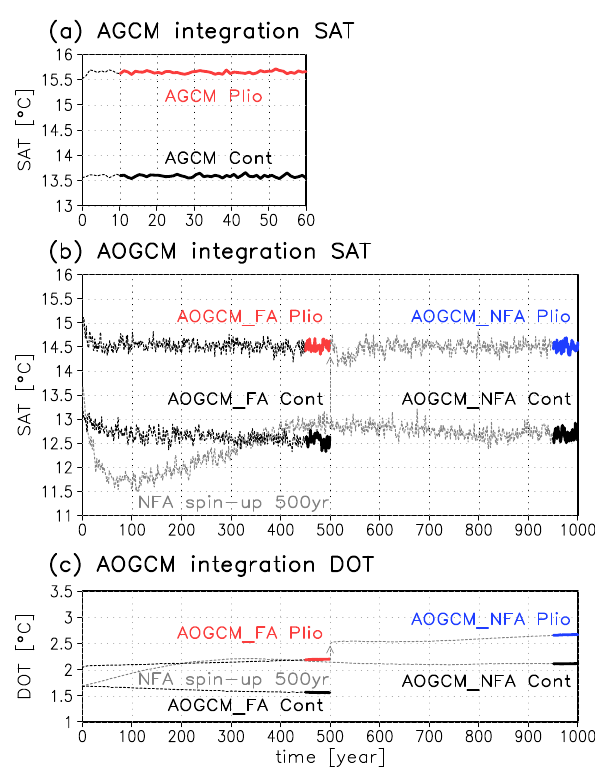
Fig. 3. Time series of the model integrations including spinups. Bold solid lines show the averaging periods of the individual simulations. (a) Globally averaged surface air temperature (SAT, °C) for the AGCM and (b) AOGCM. (c) Same as (b) but for deep ocean temperature (DOT, °C) averaged for depth below 1000 m.